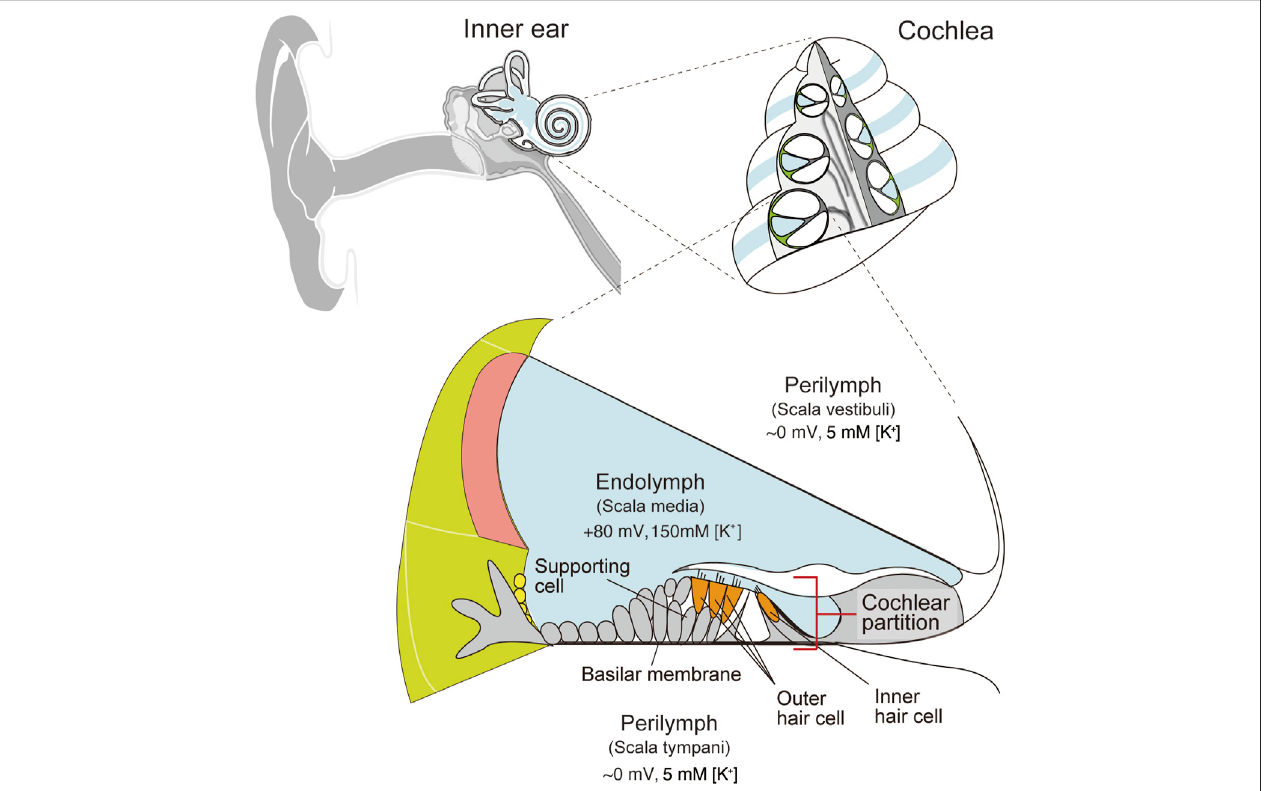
FIGURE 1 | Structure of the cochlea in the inner ear. Schematic images of a human ear and a cross-section of the cochlea are depicted in the upper left and right panels, respectively. The lower panel illustrates the tissue and cellular architecture of the cochlea. Perilymph has ionic composition similar to that of an ordinary extracellular liquid. On the other hand, endolymph maintains 150 mM K + and a highly positive endocochlear potential (EP) relative to perilymph. Cellular composition of the cochlear partition is shown as well. Inner and outer hair cells are surrounded by various types of supporting cells. These cells are mounted on the basilar membrane. Adapted from Nin et al. (2008) with permission. Copyright (2008) National Academy of